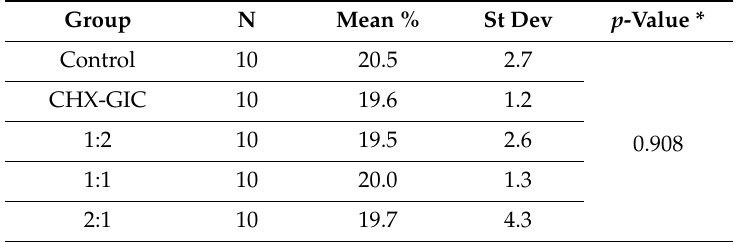
Table 1. Results of ANOVA test for water sorption of control, CHX, and three plant-modified groups